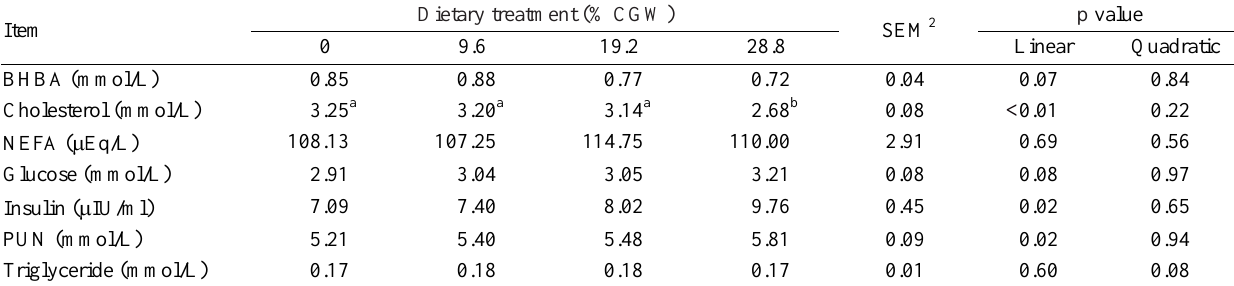
Dietary treatment (% CGW)